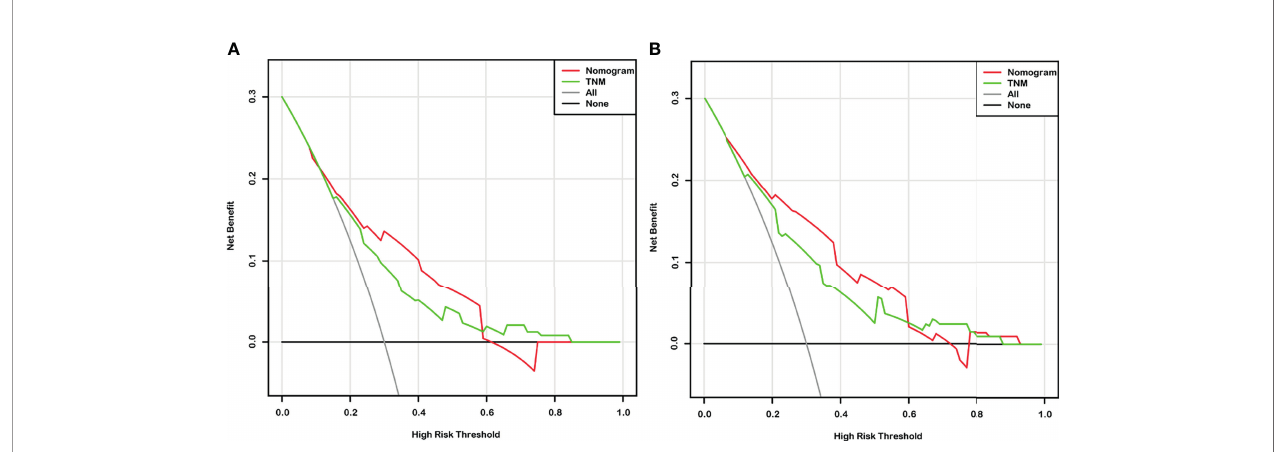
FIGURE 5 | The decision curve analysis (DCA) based on nomograms and the TNM stage for overall survival (OS) (A) and disease-free survival (DFS) (B) prediction of bladder cancer (BC) patients after